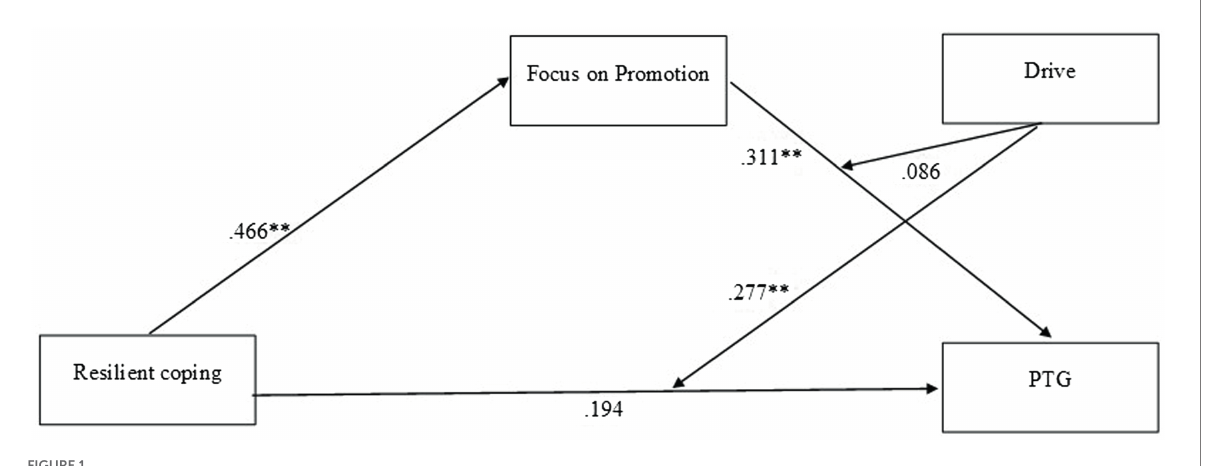
FIGURE 1 Mediating effect of focus on promotion and moderating effect of drive on the relationship between resilient coping and